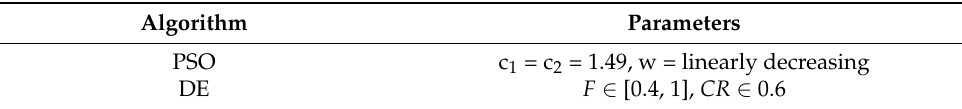
Table 2. Parameters setting of algorithms.